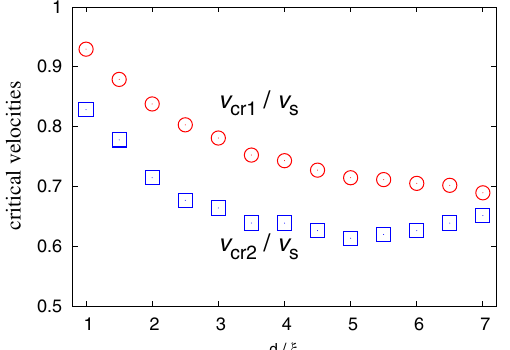
FIG. 2. Critical velocities for vortex-dipole creation versus beam waist d of a moving red-detuned Gaussian beam. When the velocity of the beam is adiabatically increased, the vortex- (circles). When the velocity of the dipole creation occurs at v cr1 beam is adiabatically decreased, the vortex-dipole creation stops (squares), and thus the system exhibits hysteresis behav- at v cr2 ior. The intensity of the Gaussian potential (5) is fixed to Þ ¼ (cid:2) 5 . = ð gn V 0 0 FIG. 1. Dynamics of the density j ~ c j 2 ¼ j c j 2 =n and phase 0 Þ ¼ = ð gn (cid:7) ¼ arg c profiles for the Gaussian potential with V 0 0 ¼ 0 : 6 , and d=(cid:2) ¼ 4 : 5 in the frame comoving with the (cid:2) 5 , v=v s potential. The phase profiles magnify the region in the dashed square. The arrows indicate the directions of circulations. The field of view of the density profiles is 160 (cid:2) (cid:5) 67 (cid:2) . The time is ¼ tv =(cid:2) . (See also Supplemental normalized as ~ t ¼ t=t 0 s Material